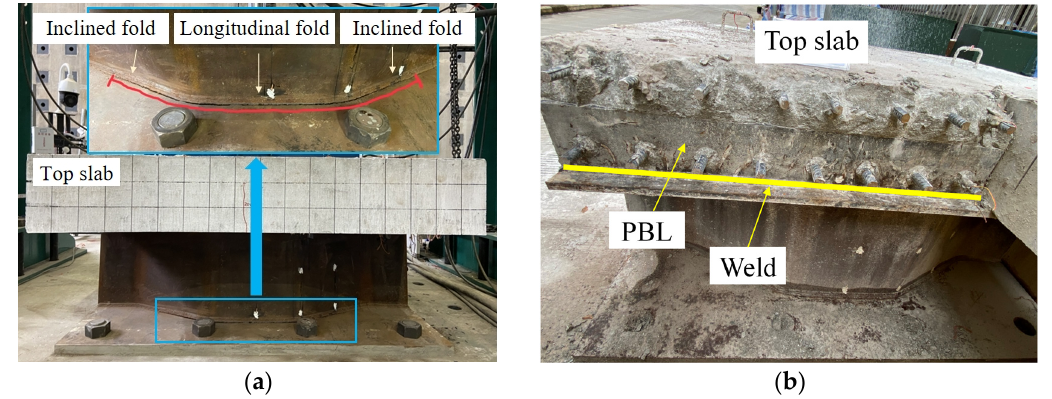
Figure 6. Failure modes: ( a ) cracking of the weld; ( b ) partial demolition of the top slab.